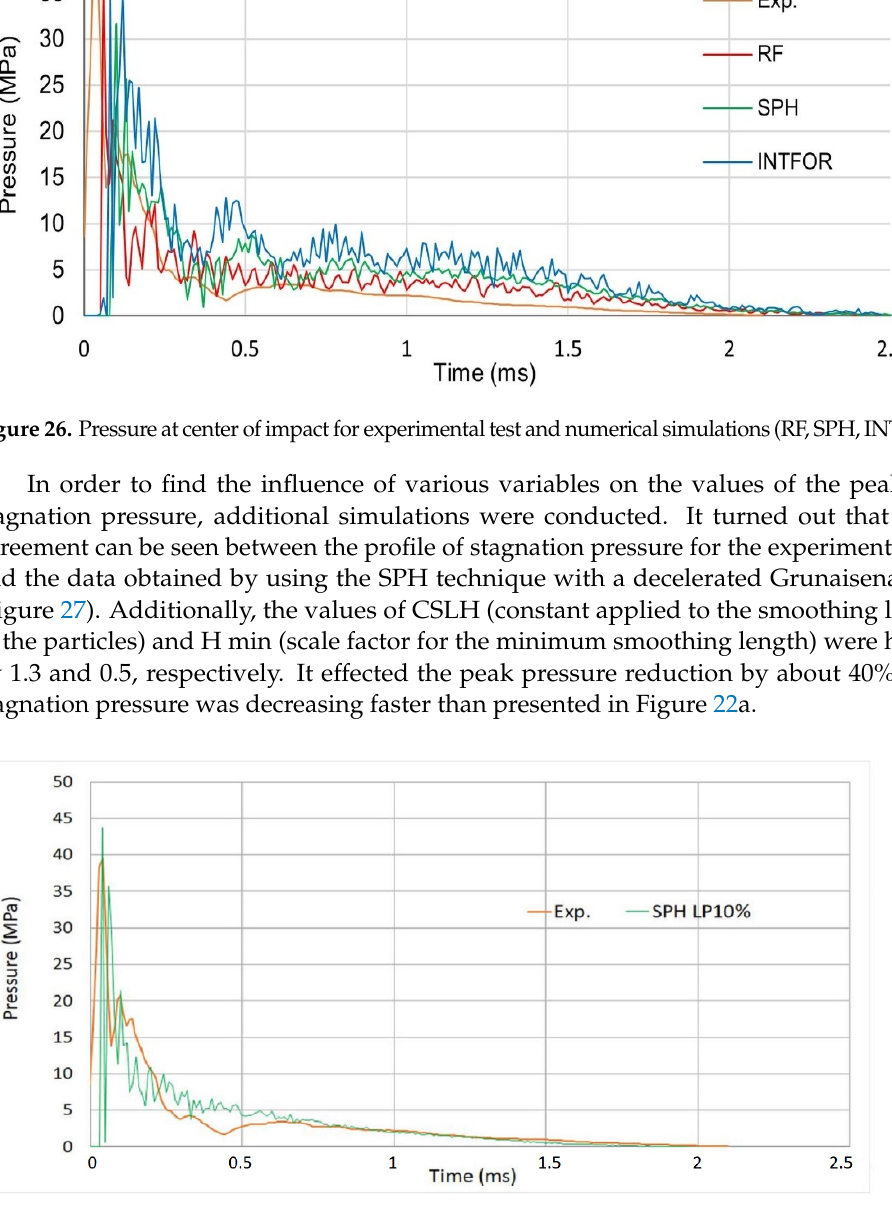
Figure 27. Pressure at center of impact for experimental test and SPH technique.